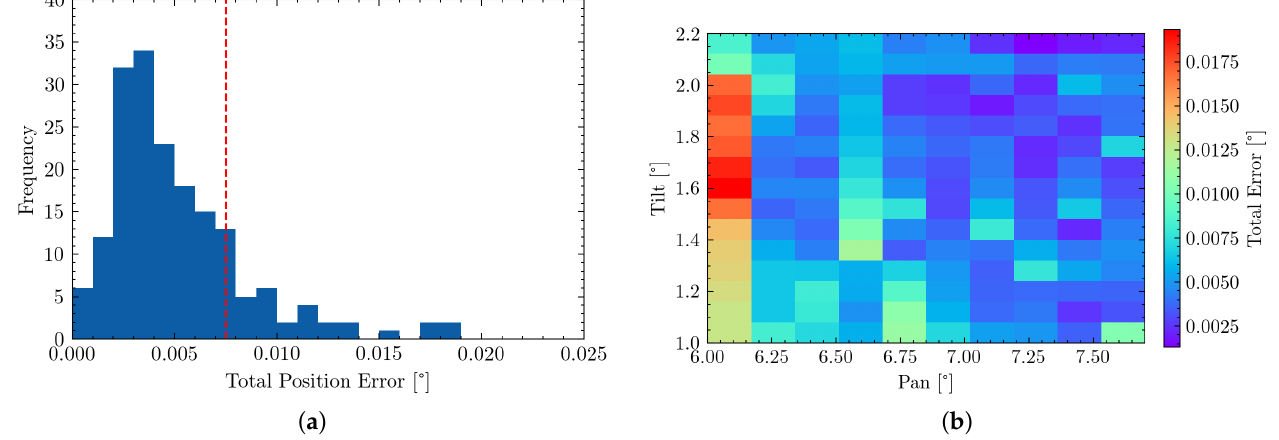
Figure 10. ( a ) and ( b ) visualize the system’s overall pointing error and its distribution. ( a ) Histrogram highlighting the distribution of RMSE pointing errors. The red line highlights our overall accuracy requirement ( b ) Heatmap visualization of pointing errors. Large red-spot due to one large mis-aligned measurement and no further points in that